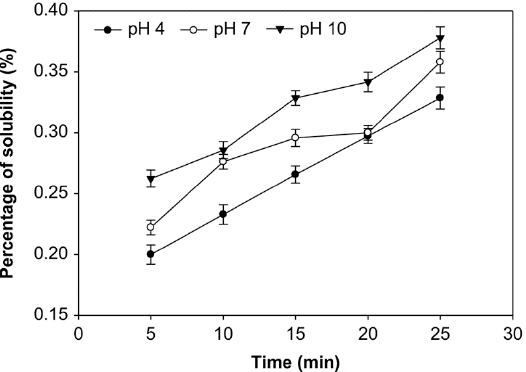
Figure 7. The effect of time on solubility at various pH with the starch concentration of 10% ( v / w ).